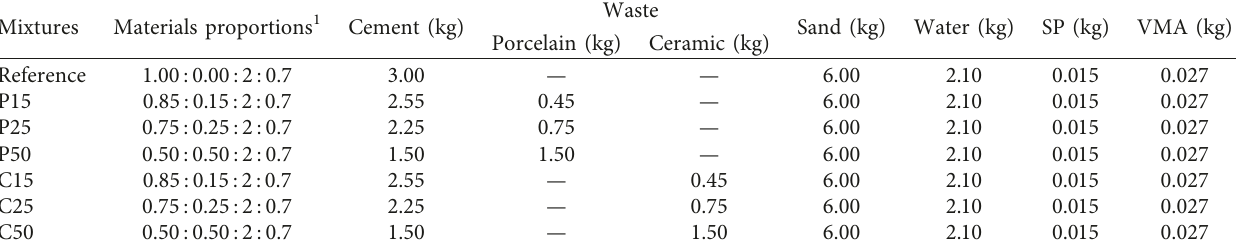
Table 2: Experimental mixtures.